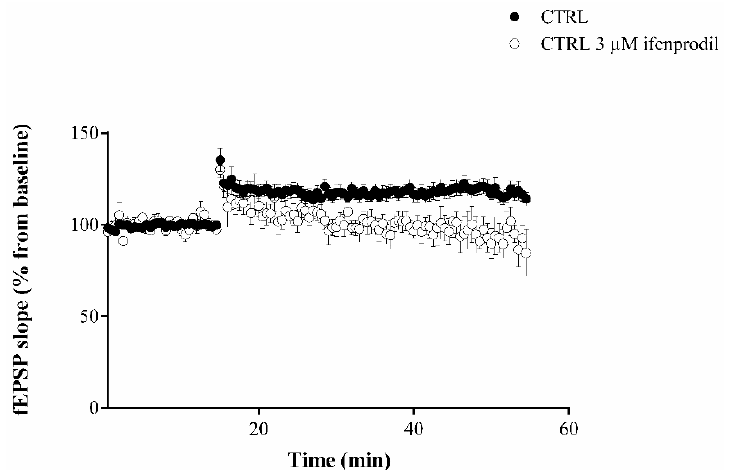
Figure 3. Long-term potentiation (LTP) in presence of ifenprodil. The slopes of the EPSP evoked by high-frequency stimulation in CTRL slices treated with 3 µM ifenprodil significantly decreased after recording for 40 min following; in addition, the y-intercept in the last 10 min of recording was significantly lower in the group treated with 3 µM ifenprodil group. Data statistical analysis: linear regression slope F = 128.141, p < 0.0001; y-intercept F = 566.889, p < 0.0001.